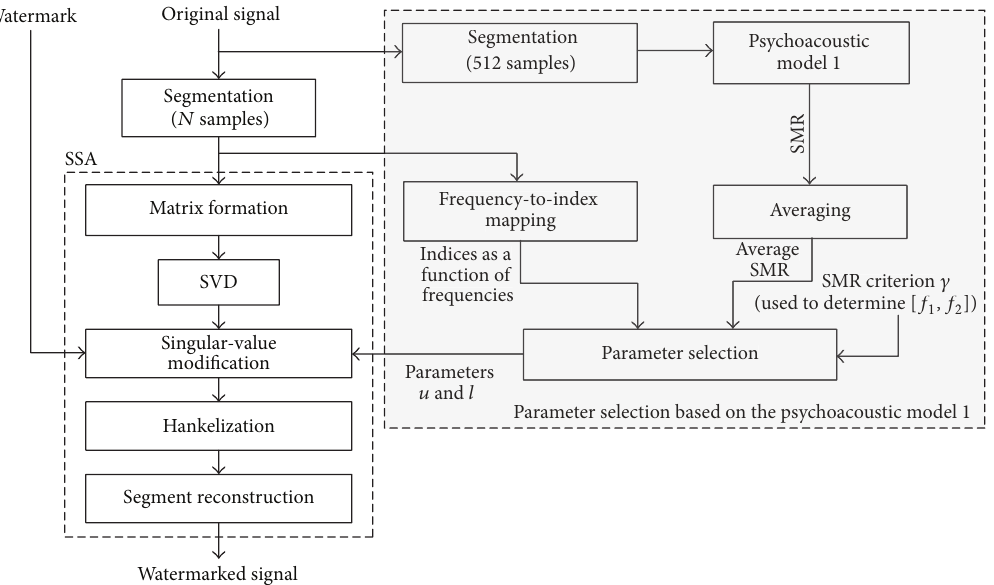
Figure 2: Embedding